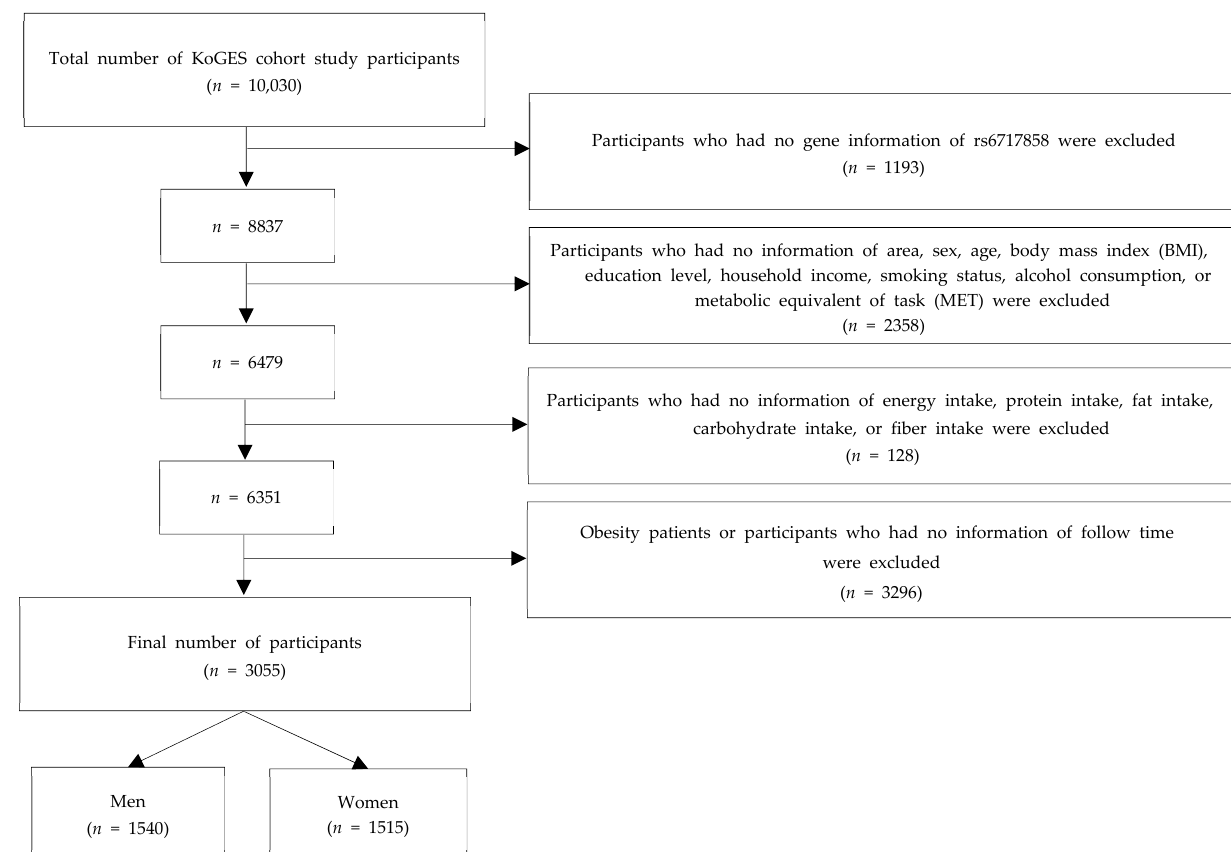
Figure 1. Process flow diagram outlining the steps involved in the recruitment process.